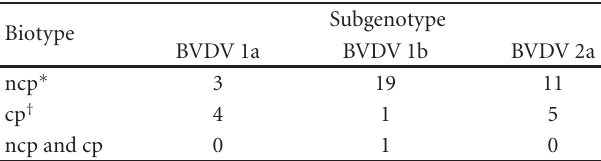
Table 1: Biotype and subgenotype distribution of BVDV